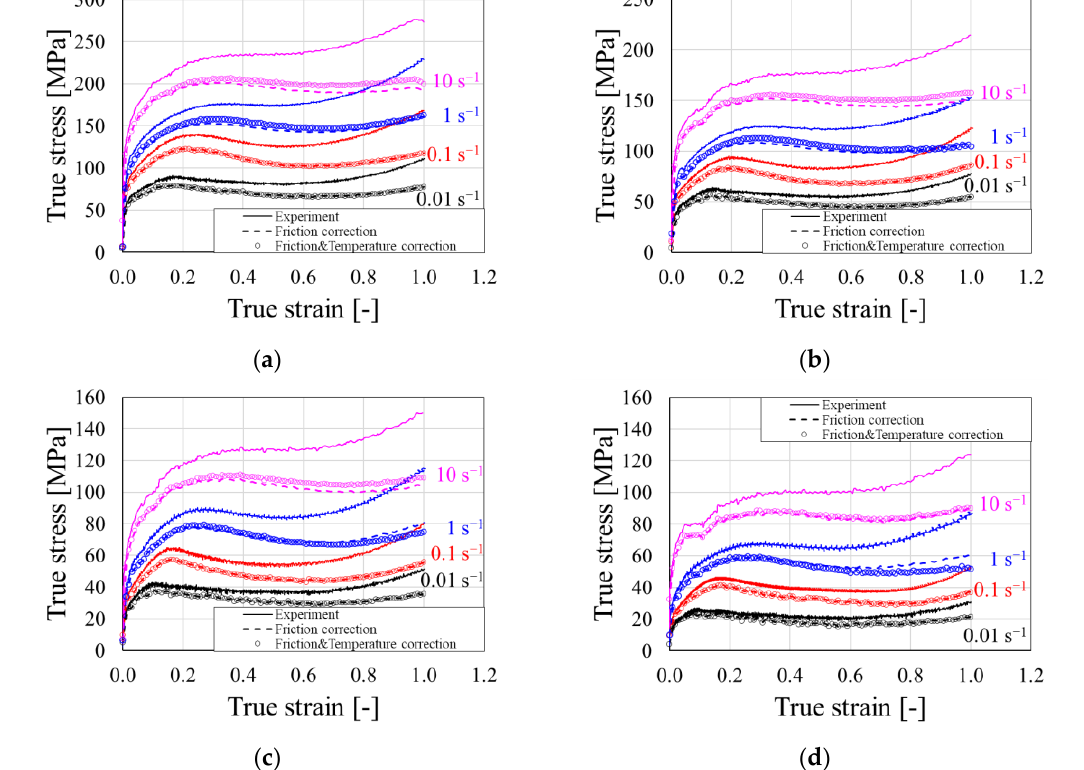
Figure 4. True stress-strain curves of the experiment were corrected under different deformation conditions: ( a ) 900 °C, ( b ) 1000 °C, ( c ) 1100 °C, ( d ) 1200 °C.